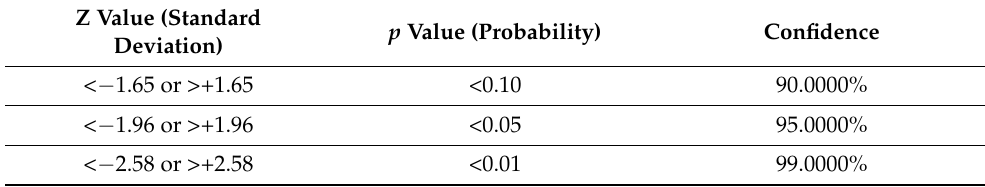
Table 5. Value evaluation